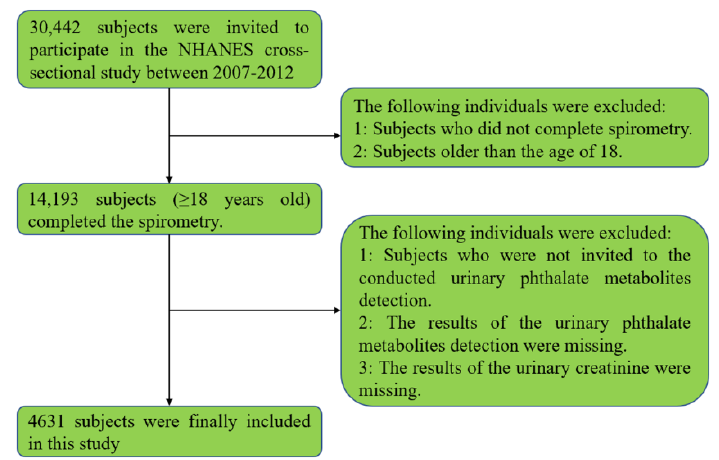
Figure 1. The study flow chart of identifying eligible subjects. Table 1. The characteristics of study population and the difference between groups with and with- out lung function impairment.